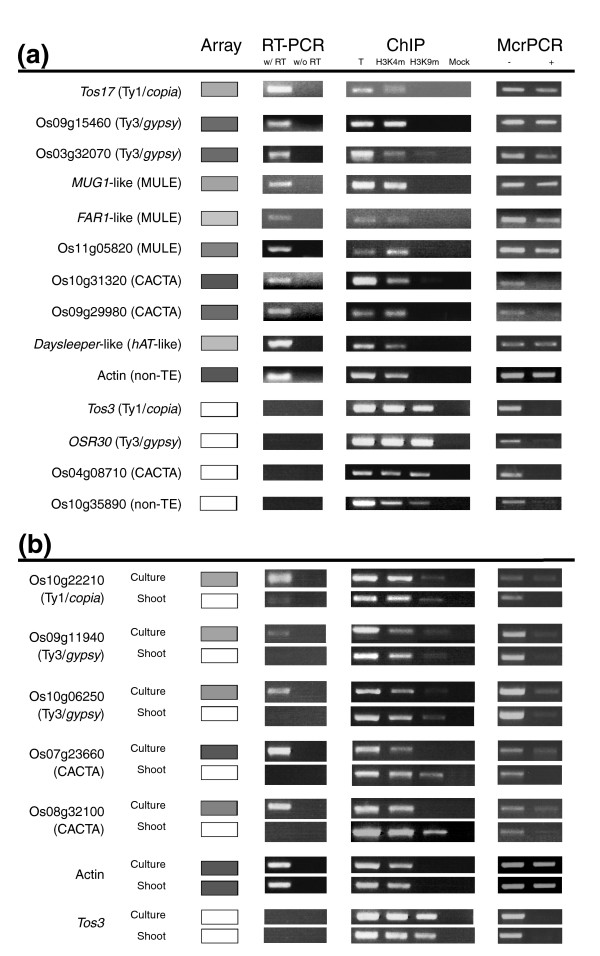
Chromatin-level modifications of TE-related genes. Reverse-transcribed cDNA, DNA from ChIP, and McrBC-digested genomic DNA were amplified by PCR for TE-related genes (a) with and without transcription in seedling shoots, and (b) with transcription in cultured cells but not seedling shoots. Primers corresponded to transcribed ORFs. Mock RT-PCR was performed without reverse transcriptase (w/o RT). ChIP was carried out with histone H3 anti-dimethyl lysine-4 (H3K4m) or anti-dimethyl lysine-9 (H3K9m) antibodies together with total DNA input (T) and no antibody (Mock) controls. McrPCR was performed on McrBC digested (+) and untreated (-) total genomic DNA. Actin was used as a positive control and Os10g35890, a gene of unknown function without transcription in seedlings, as a negative control. The same gray scale was used to indicate magnitude of transcription signals from microarray (Array). ChIP, chromatin immunoprecipitation; ORF, open reading frame; PCR, polymerase chain reaction; TE, transposable element.